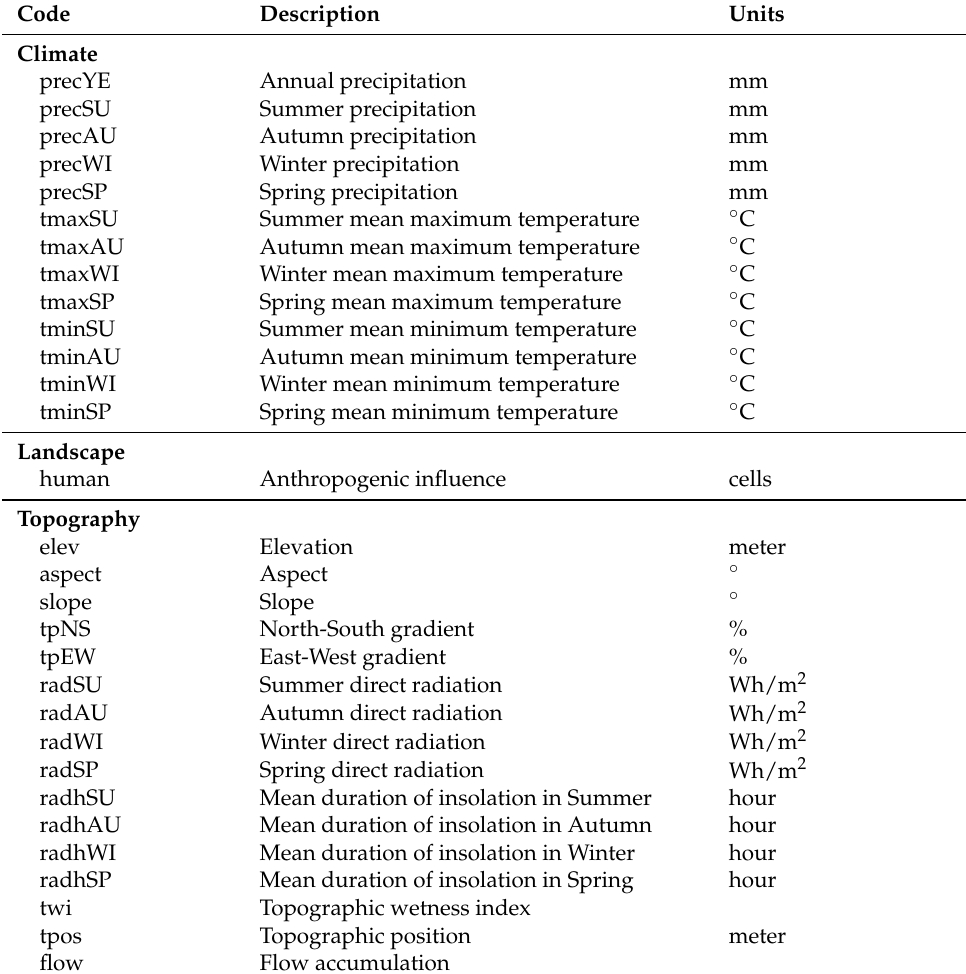
Table 2. Description of environmental variables and forest attributes used in our